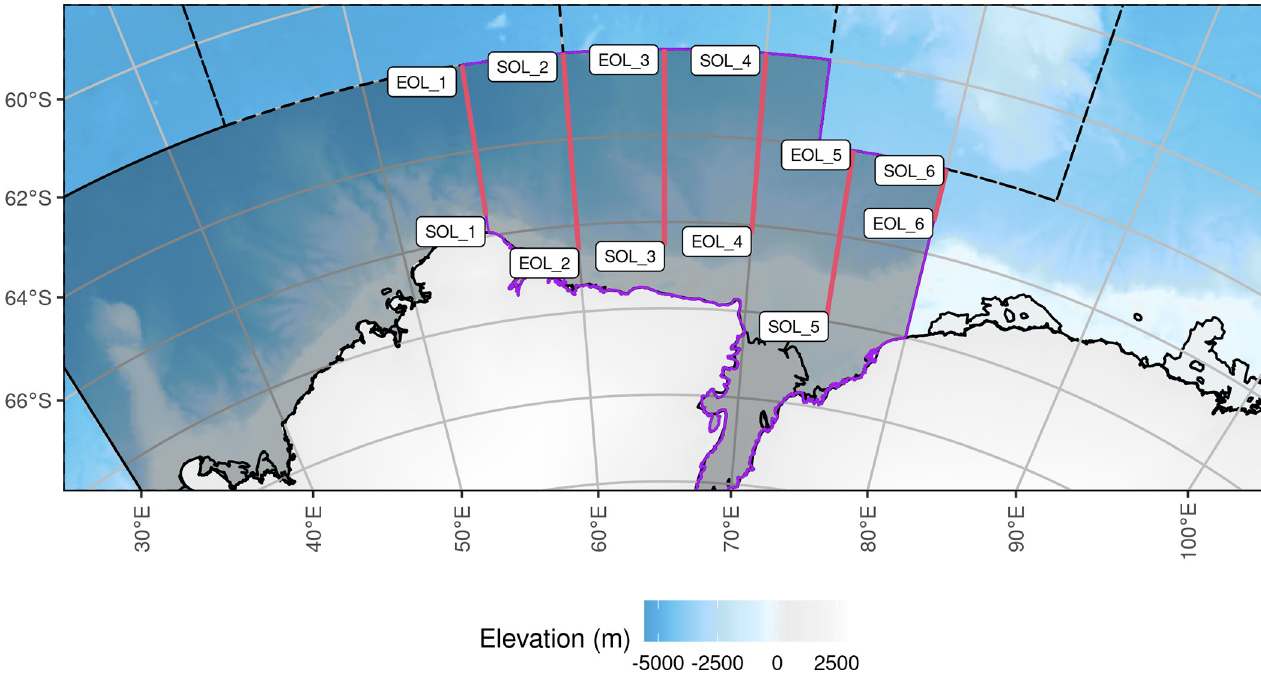
Fig 1. Planned survey transects designed to cover the eastern sector of CCAMLR Division 58.4.2 from 55˚E to 80˚E (solid border, dark area), with other CCAMLR Division borders shown as dashed lines. The sector of Division 58.4.2 covered by the survey is shown with a purple boundary. The survey transects are solid red lines, labelled with the start-of-line (SOL) and end-of-line (EOL). Acoustic samples (integration intervals) that fall outside of Division 58.4.2, i.e. the northern ends (north of 64˚S) of transects 5 and 6, were not used in krill density and biomass estimation. The background bathymetry grid is from The GEBCO_2014 Grid, version 20150318,